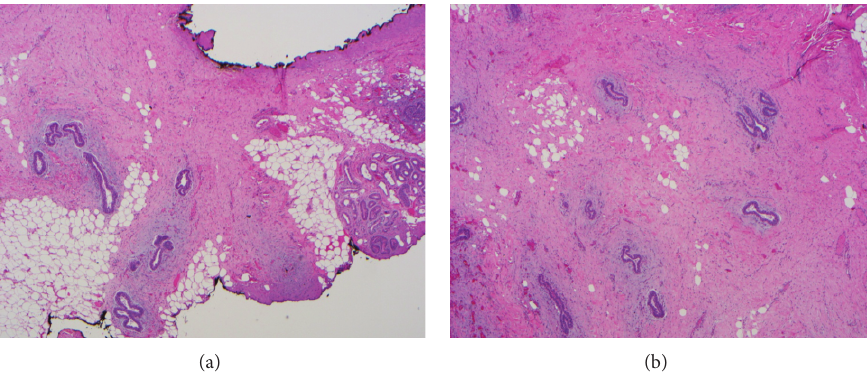
Figure 2: (a) Histopathology examination revealed an ill-defined lesion composed of irregularly proliferating mammary ducts with no lobules. The surrounding stroma was reactive and exaggerated. (b) The lesion extended adjacent to the axillary skin adnexa. Evenly distributed irregularductswithperiductalstromalproliferationwerepresent,withoutatypia,consistentwithadiagnosisofgynecomastia-likehyperplasia within an ectopic mammary tissue